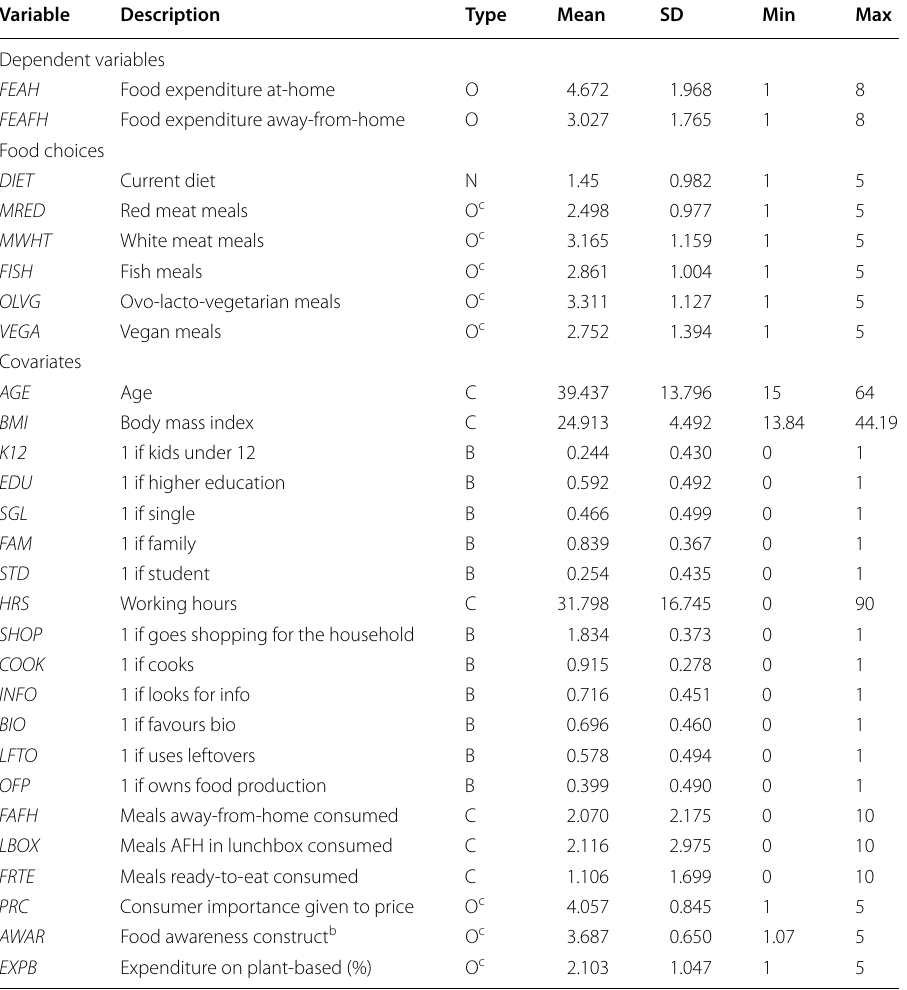
Table 3 Summary of the variables